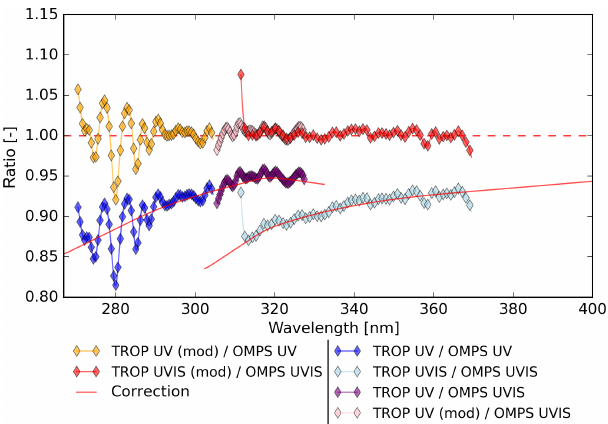
Figure 20. The TROPOMI UV and UVIS spectra via QVD1 (blue, purple and light blue), divided by the OMPS spectrum. The ratio differs between bands 2 (purple) and 3 (light blue) in the spectral overlap region of TROPOMI. In orange, pink and red the modified spectra are shown. They were modified with the cubic splines as indicated by the red lines. All spectra are convolved with a 1.0nm Gaussian kernel.